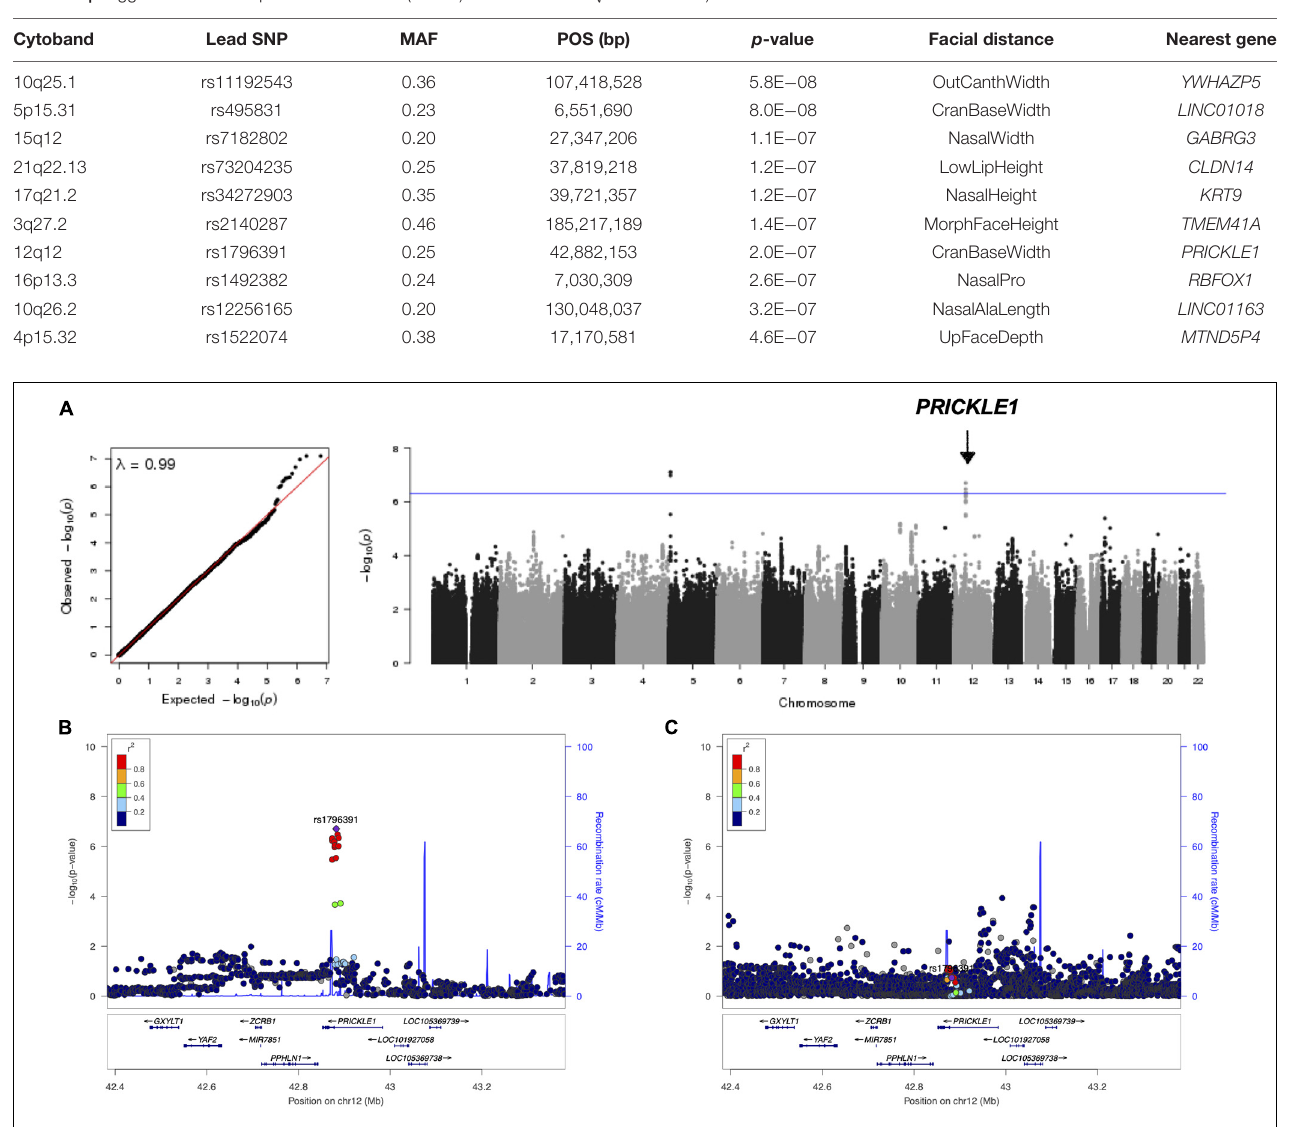
FIGURE 1 | Results of the genome-wide variance quantitative trait locus (vQTL) analysis for cranial base width. (A) Q–Q plot and Manhattan plot. There was no sign of inflation. The arrow points to the PRICKLE1 locus on chr12. The blue horizontal line indicates suggestive threshold 5 × 10 - 7 . The bottom two plots show the association –log 10 ( p -value) at the PRICKLE1 locus with the variance (B) and the mean (C) of cranial base width.